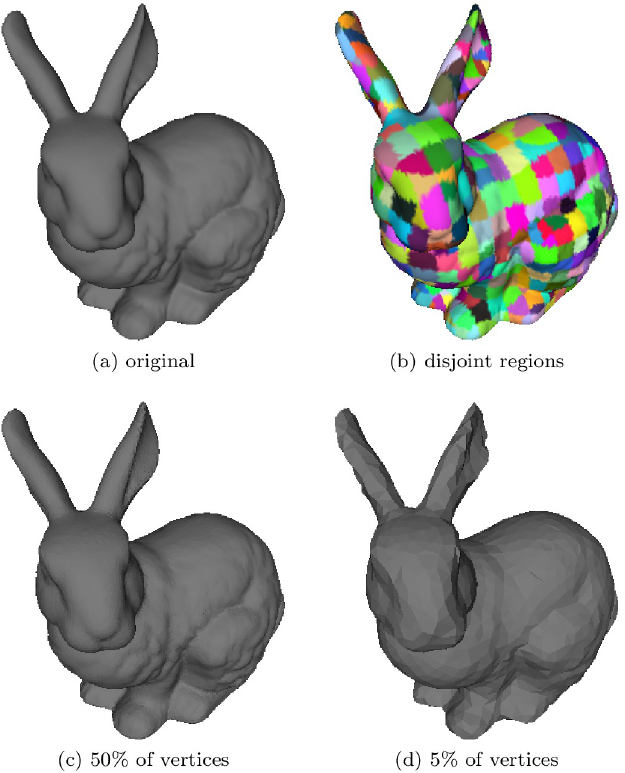
Fig 1. Overview of the proposed simplification process. (a) Stanford bunny, and (b) identification of disjoint parts; (c), (d) simplified versions of the mesh. The percentage here reflects the number of vertices with respect to the number of vertices of the original